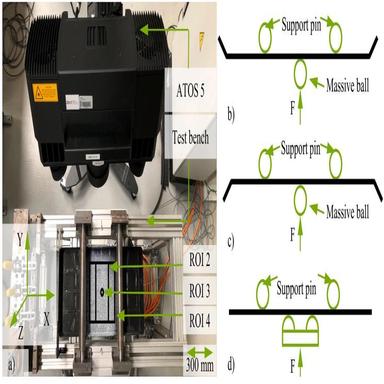
Close-up of the test cell for ball-on-cylinder test and generated regions of interest (ROIs) (a), illustration of loading on the 3D part: upwards with cylinder contact on the side wall (unless otherwise specified) (b), downwards with cylinder contact on the bottom (c), and four-point flexural test on the 2D plate (d).